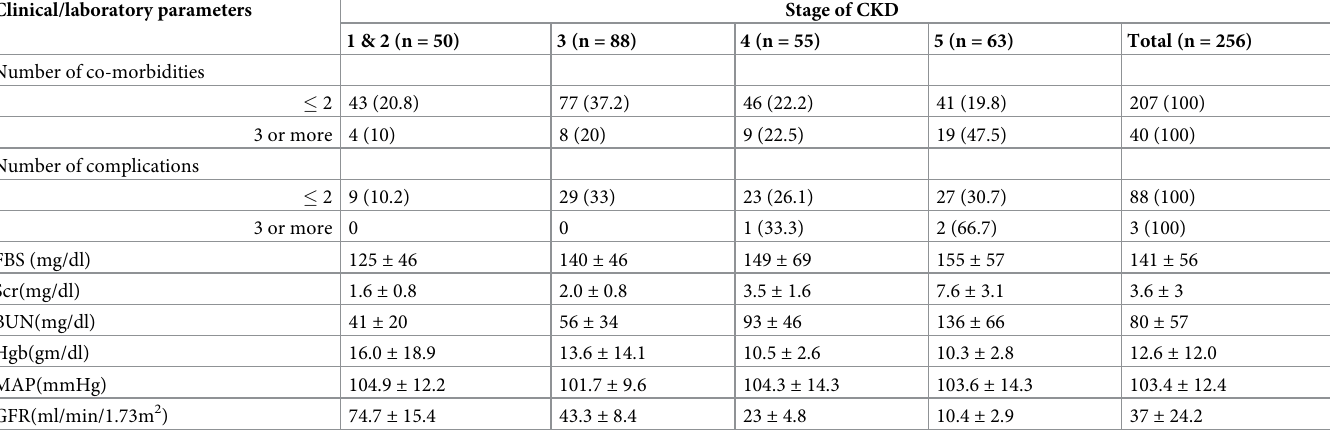
Table 2. Clinical and laboratory parameters according to the stage of chronic kidney disease patients attending the renal clinic of Tikur Anbessa Specialized Hospital. Clinical/laboratory parameters